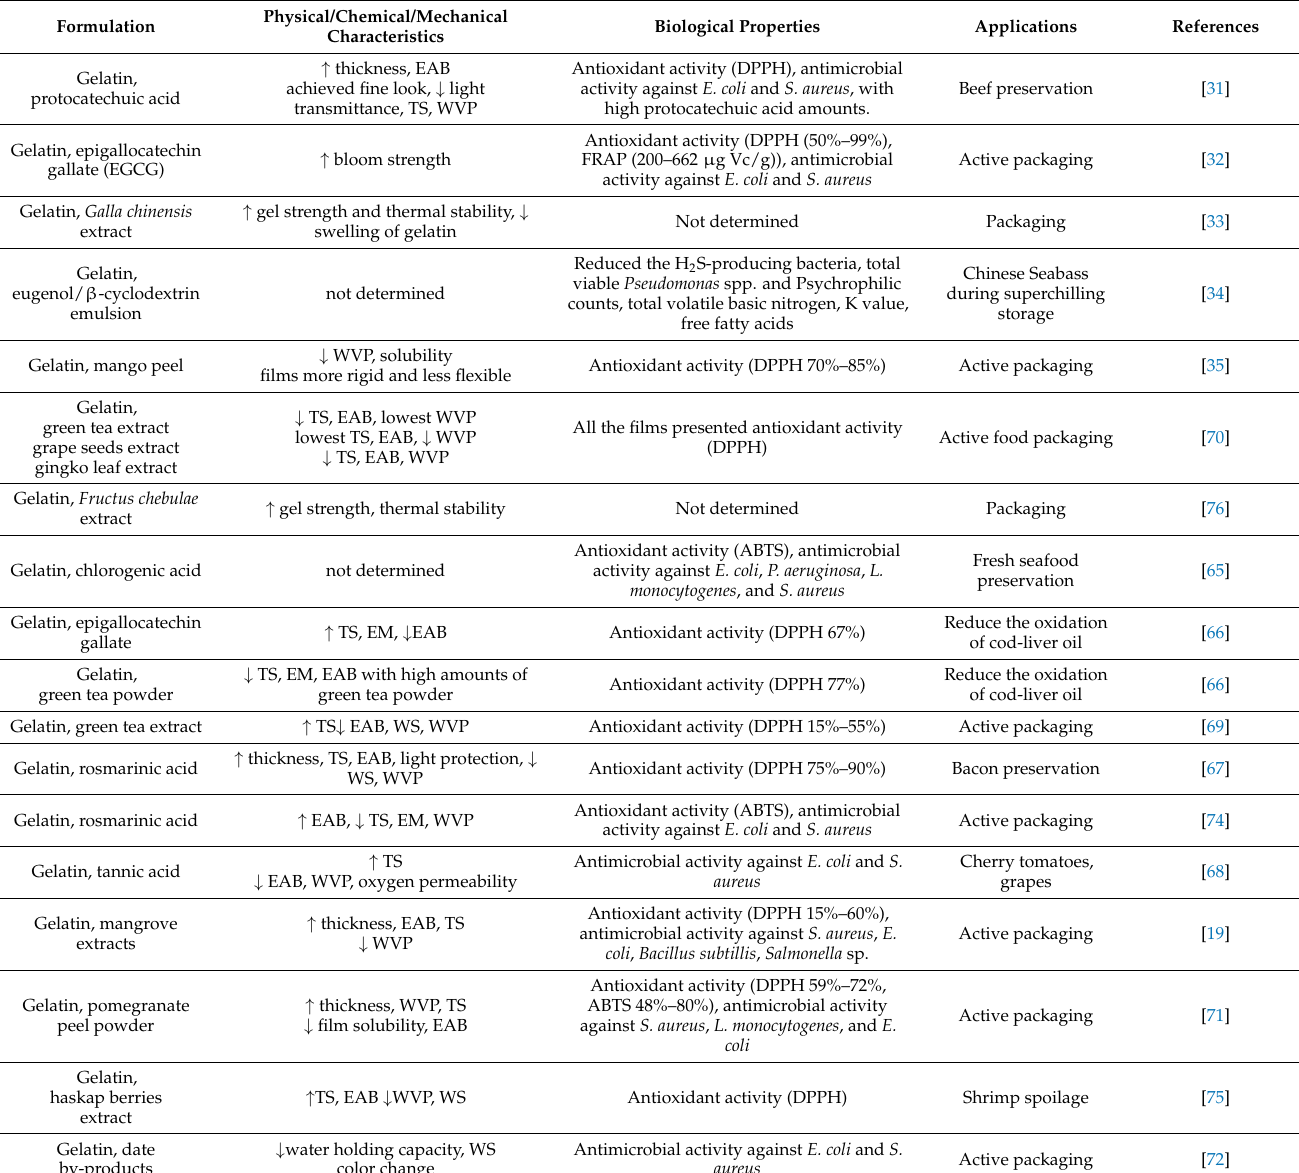
Table 2. The characteristics of gelatin–polyphenol